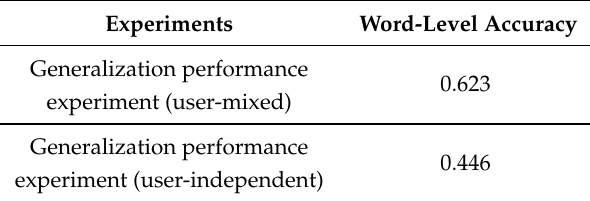
Table 6. Experimental results of generalization performance